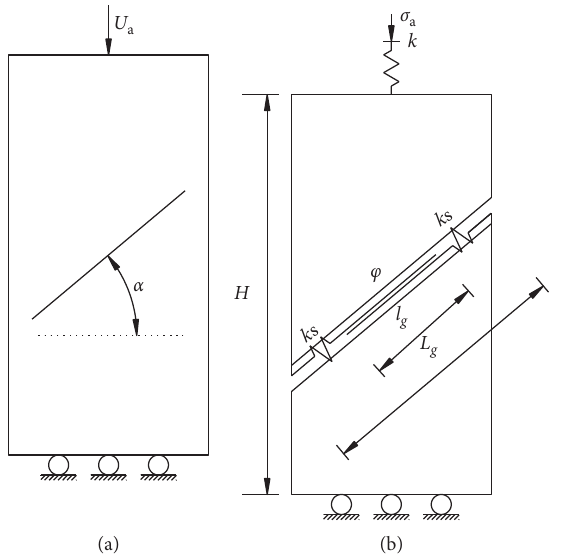
Figure 1: Brady model of coal body containing joints. (a) Coal with a single joint. (b) Equivalent physical model.